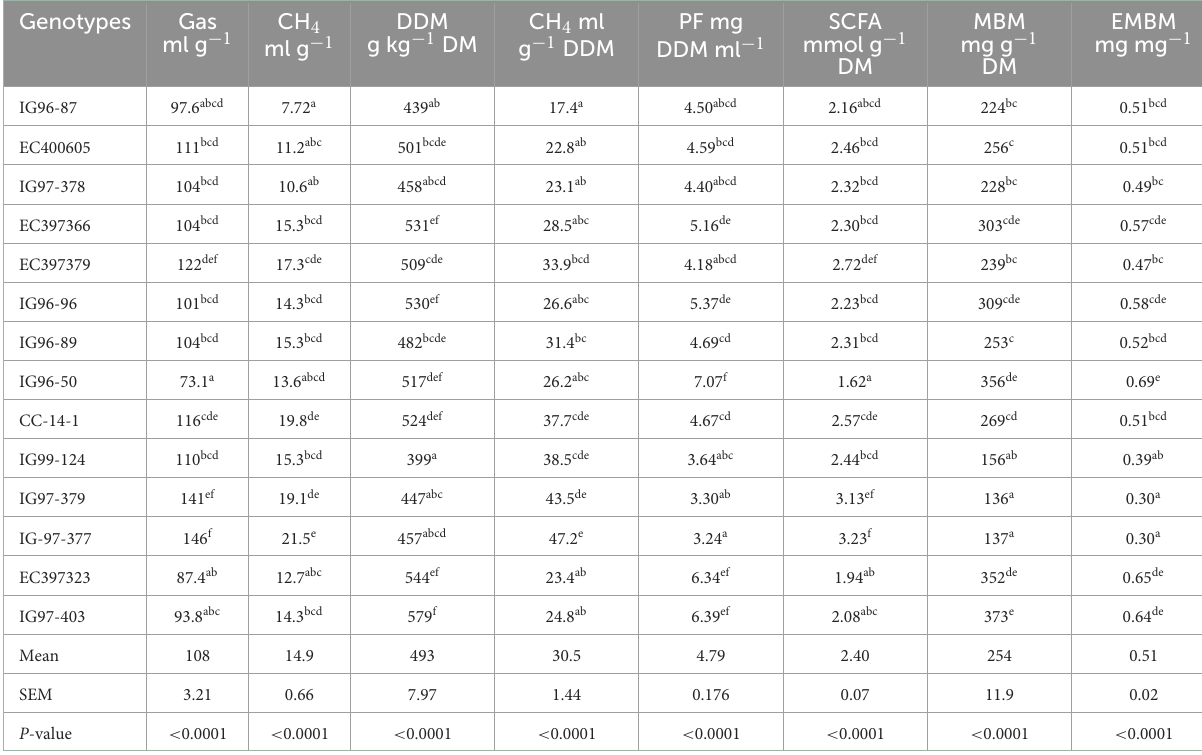
TABLE 7 In vitro gas and methane production from sugar-rich Cenchrus ciliaris accessions.